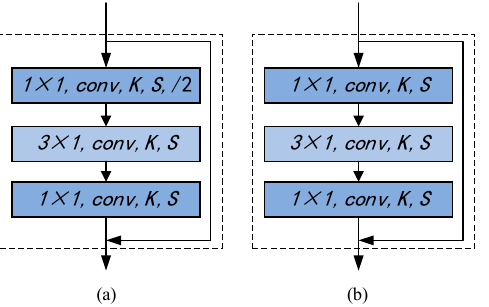
Figure 6. Example of two residual modules. The residual module ( a ) indicates that it has been downsampled, while the residual module ( b ) indicates equal-width convolution.